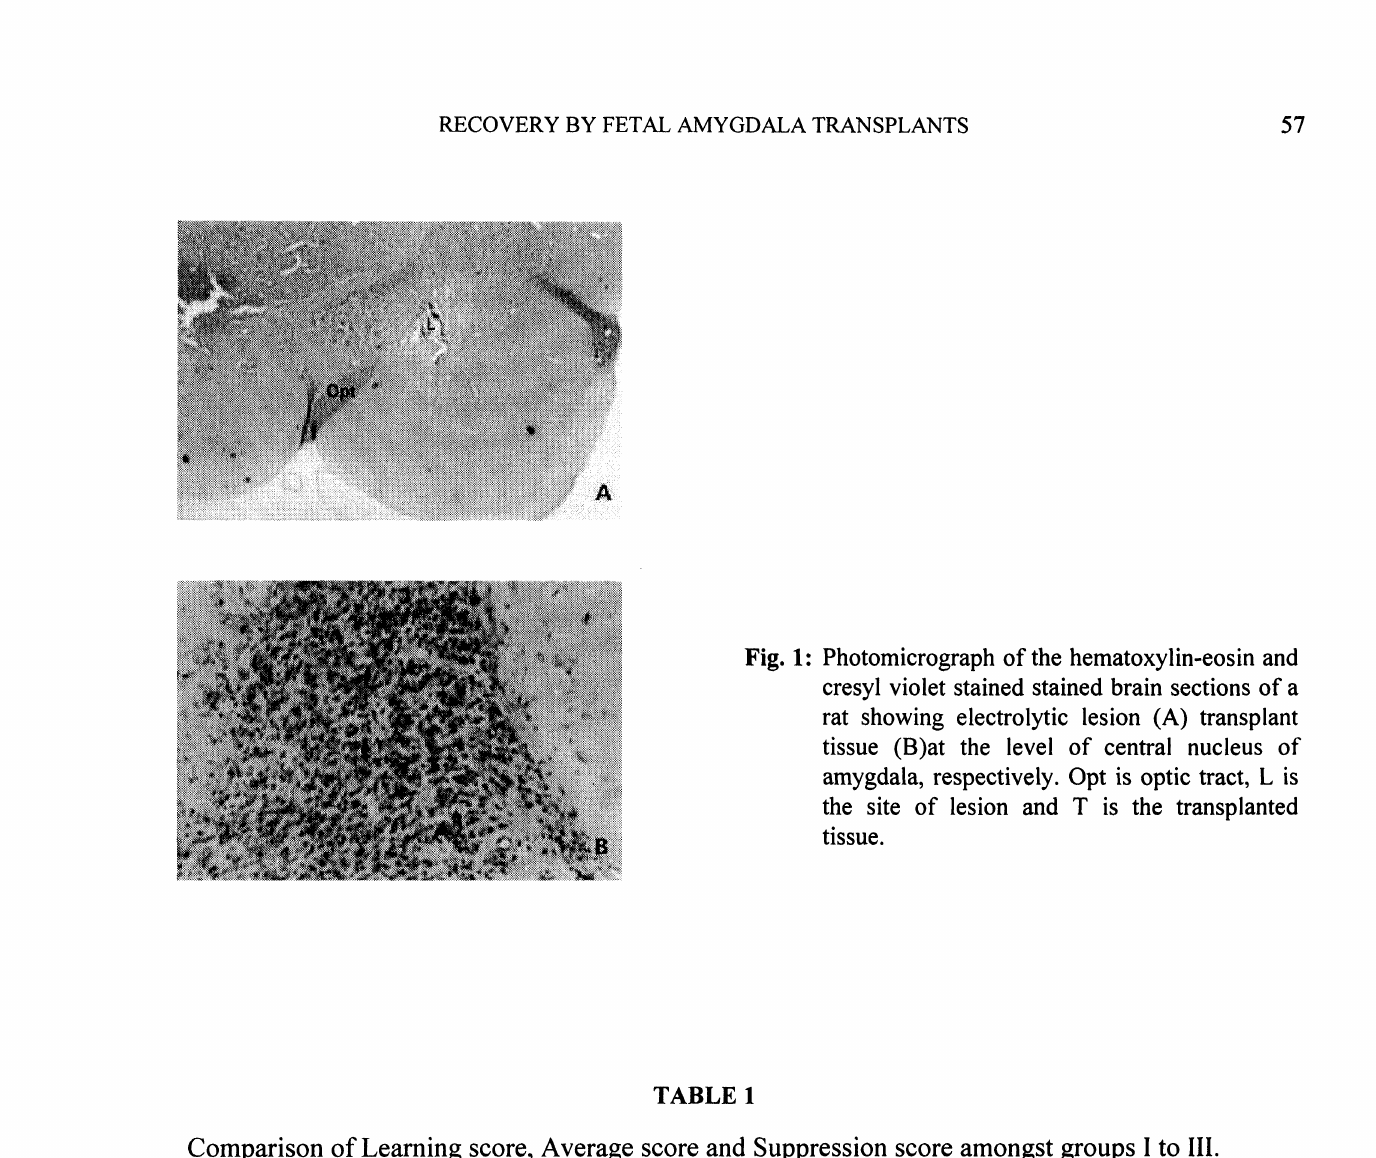
Comparison of Learning score, Average score and Suppression score amongst groups to